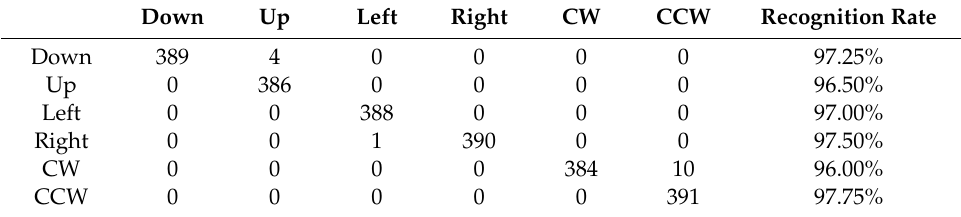
Table 4. Recognition counts and rates of the gestures conducted by four users (trial number is 400). Down Up